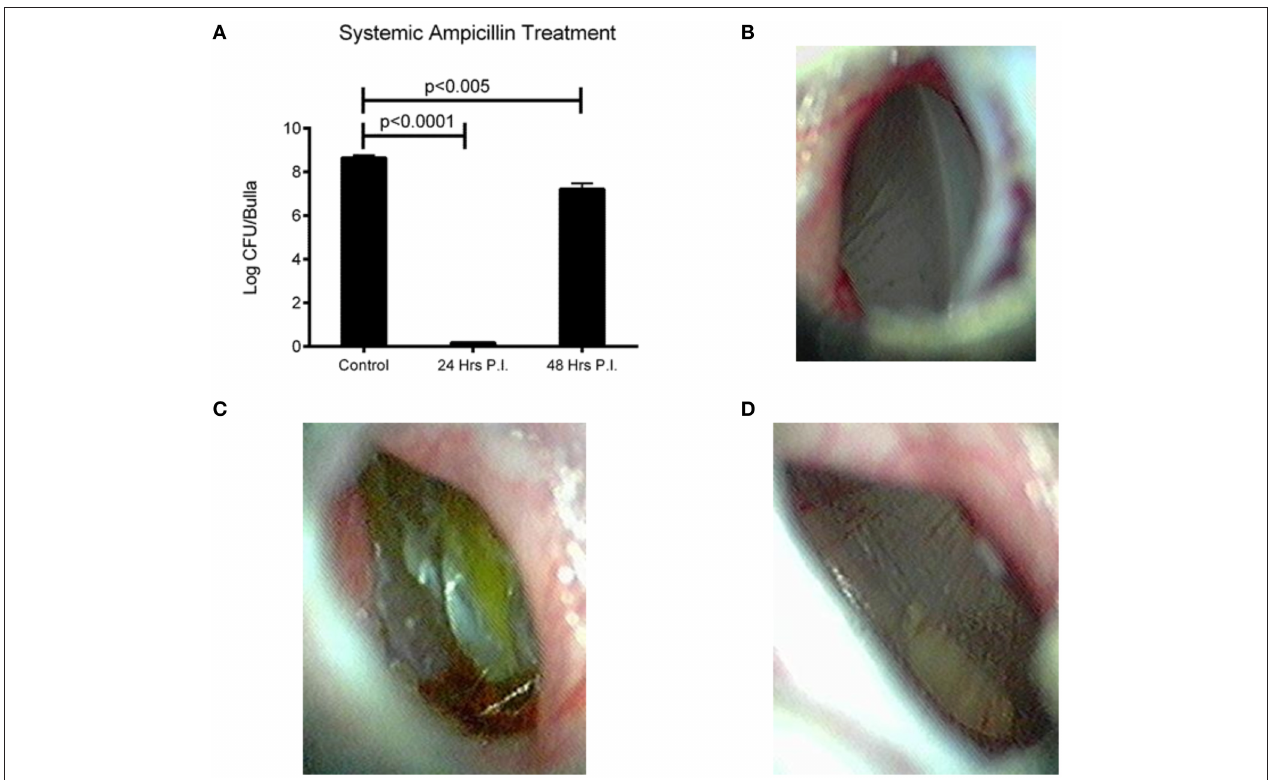
FIGURE 4 | Effect of bacterial burden and clinical symptoms of systemic ampicillin treatment of EF3030 OM model. (A) Untreated animals had high levels of recovered bacteria and ampicillin treatment significantly reduced bacterial burden. Treatment starting 24 h post-infection cleared all detectable bacteria from the middle ear and treatment starting 48 h post-infection had a smaller, but significant reduction in recovered bacteria. (B) Tympanic membrane of animal 72 h post-infection and 48 h after start of treatment. (C) Tympanic membrane of mock treated animal 72 h post-infection. (D) Tympanic membrane of animal 72 h post-infection and 24 h after start of treatment. Data represents samples from four bullae and representative